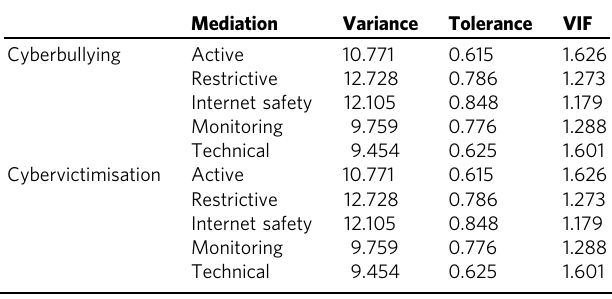
Table 4 Multicollinearity and variance values for regression analysis of strategy on cyberbullying and